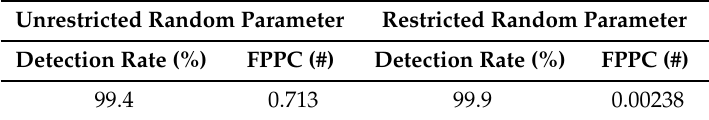
Table 4. Comparison of the effects of the augmentation method on the performance of the result. Unrestricted Random Parameter